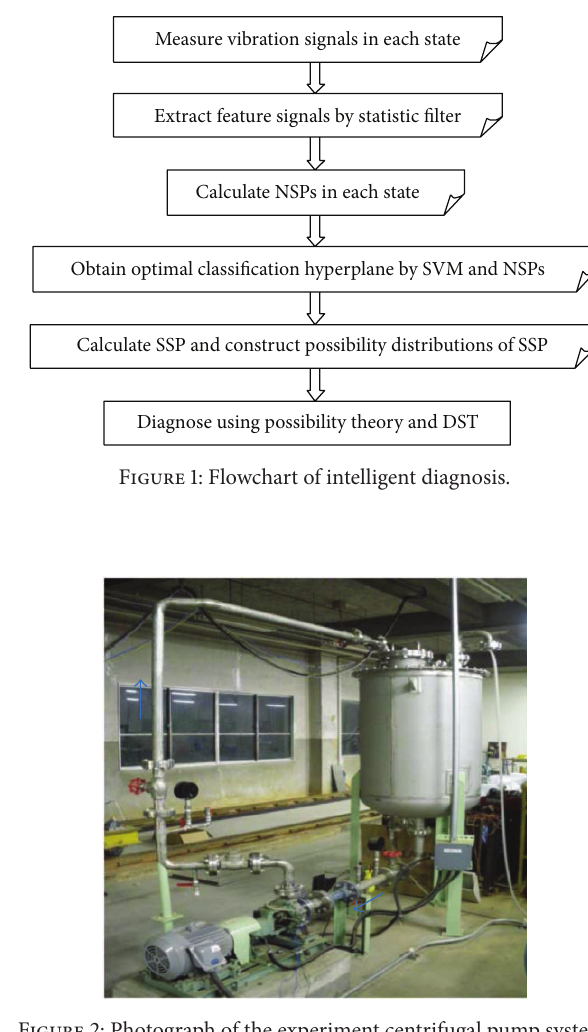
Figure 2: Photograph of the experiment centrifugal pump